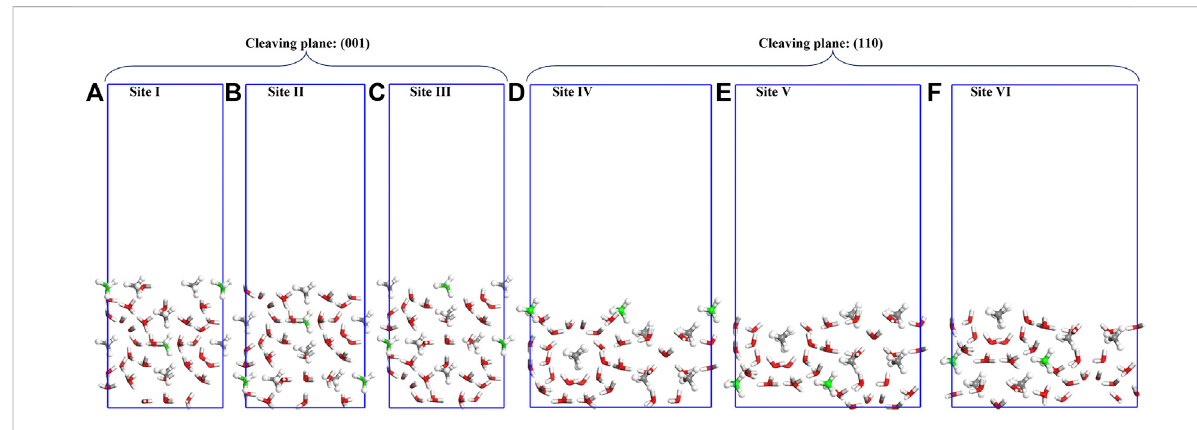
FIGURE 2 Cleaved slabs along (001) and (110) planes of sI-MH with 20Å vacuum in depth: (A – F) are cleaved slabs along different sites (Sites-I to Site-VI). The white, grey (green), and red spheres denote H, C, and O atoms, and CH 4 with grey and green C atoms are from large and small water cages,